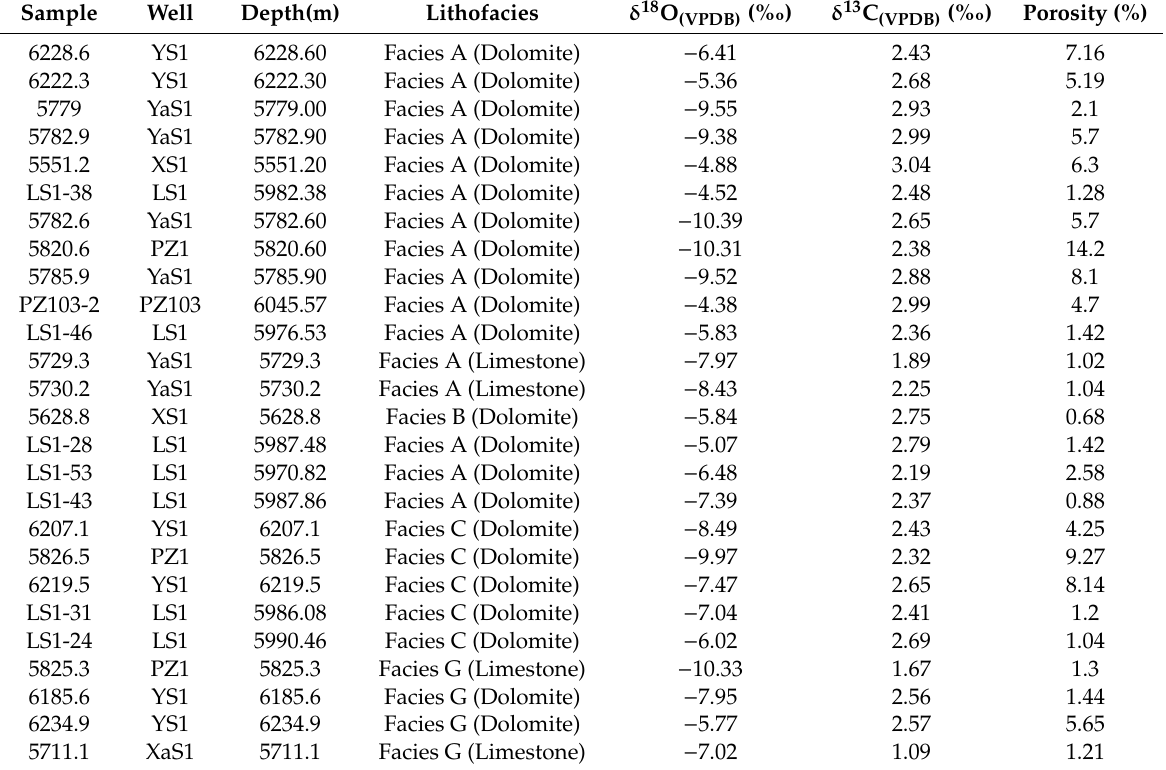
Table 5. Values of stable carbon and oxygen isotopes of di ff erent lithofacies in the fourth member of the Leikoupo Formation.